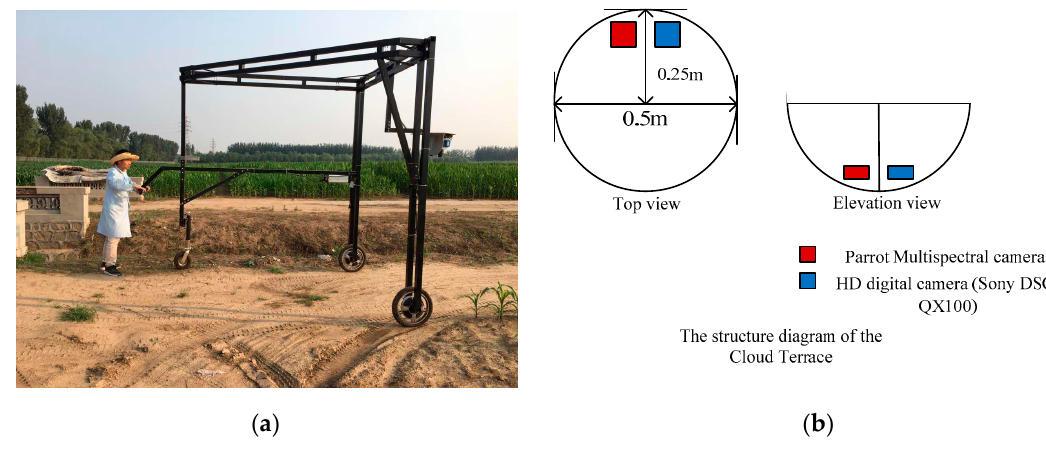
Figure 2. Field operating diagram and photograph of field-based phenotype platform (FPP) ( a ) and of vehicle-mounted cloud terrace ( b